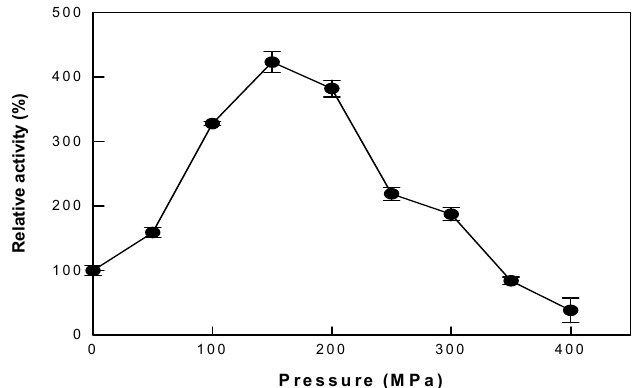
Figure 2. The activity of cytolase PCL5 with changes in pressure. Data represent the means of three experiments ± standard deviation.